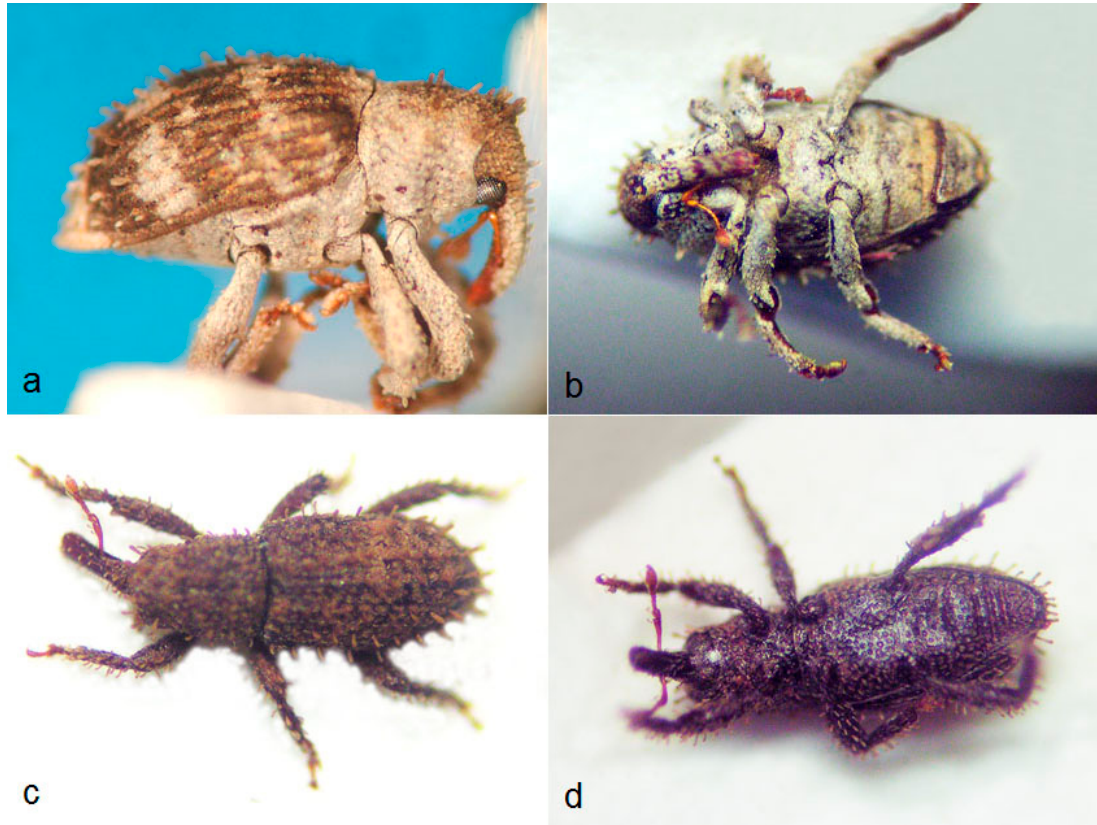
Figure 10. Weevils with doubtful assignments II. The weevil on the first photos ( a , b ) is provisionally regarded as Ithyporini. Species with a similar habitus look like inhabitants of the soil, but they were found in rather large numbers in the tree crowns; usually, they have a rostral furrow. In the last small species, such a furrow is absent, and this species is regarded provisionally as Seticotasteromimus (Pissodini) or a closely related genus ( c , d ).